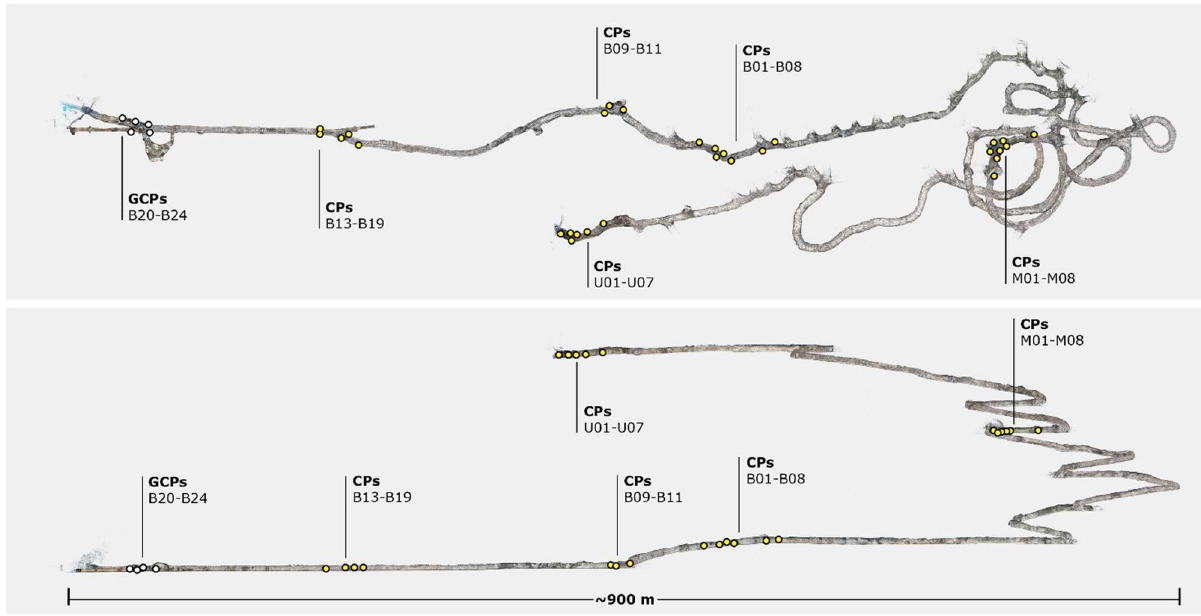
Figure 1 . 3D reconstruction of the IMI Fabi mine, with ground control points (white) and checkpoints (yellow) locations.